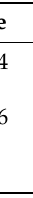
Figure 12. Linear regression between average velocity at the opening and u (cid:2868) (cid:3364)(cid:3364)(cid:3364) (cid:2868).(cid:2872)(cid:2875) (cid:4666)1.00 (cid:3398) sinα(cid:4667) (cid:2869).(cid:2868)(cid:2875) .